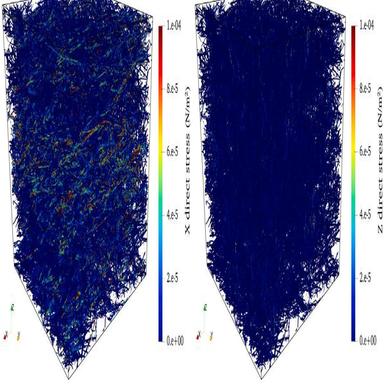
Direct stress in (left) and z (right) for FiberFormTM sample A for the elasticity simulations in the and directions, respectively.